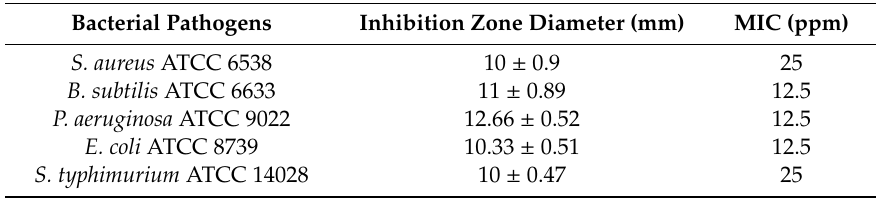
Table 1. The inhibition zones and minimum inhibitory concentration (MIC) values of the biosynthesized Ag-NPs against pathogenic